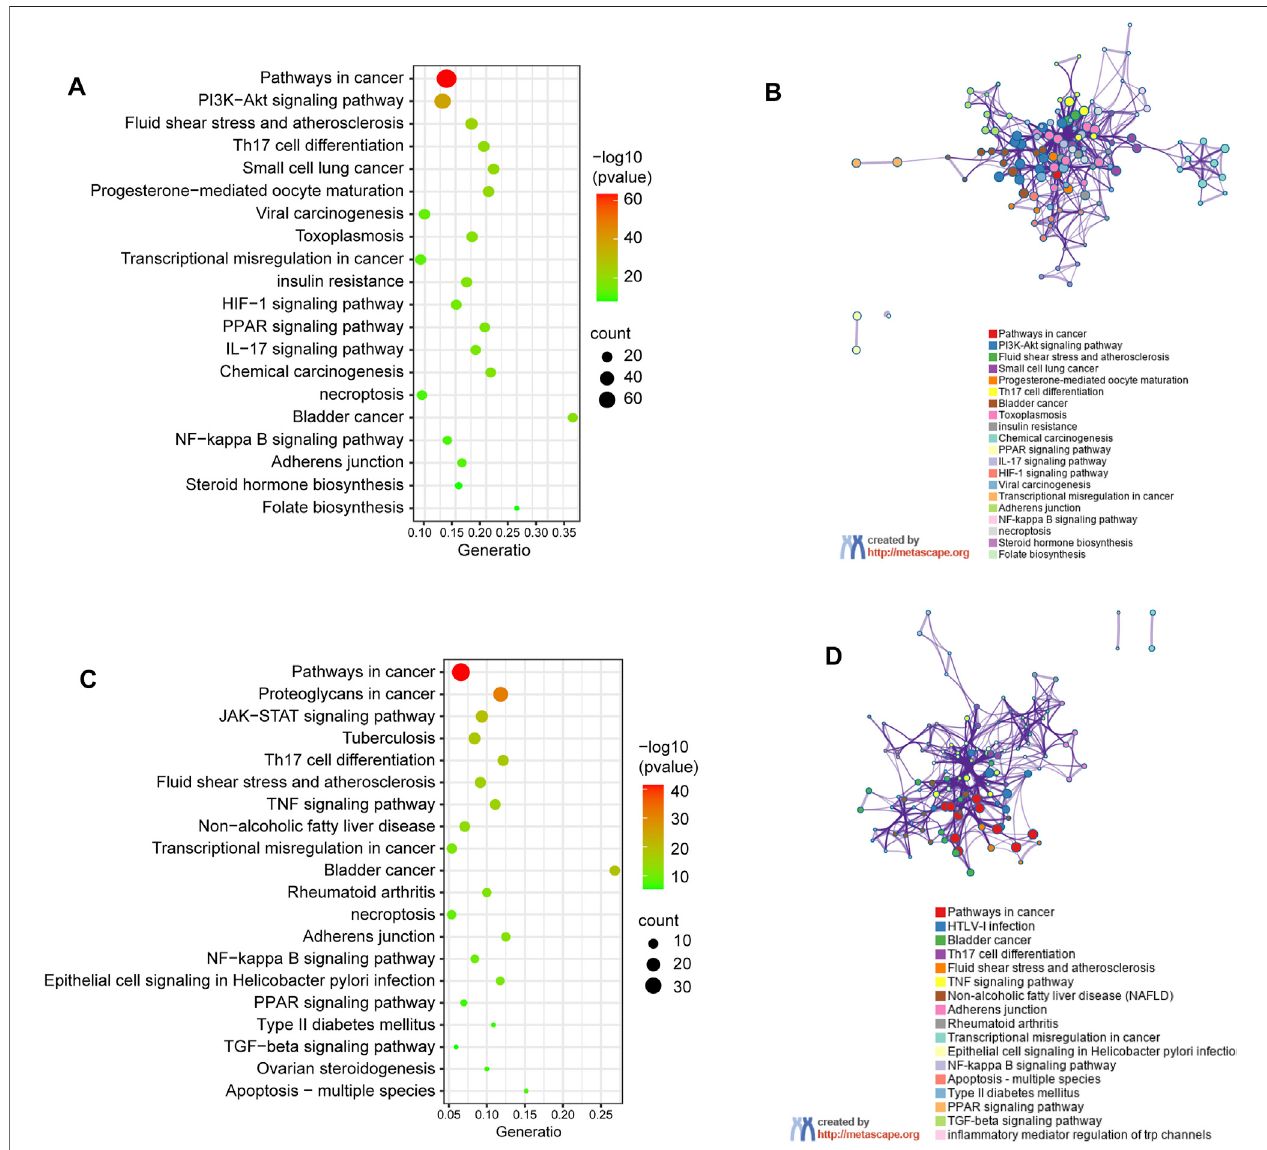
FIGURE4| KEGGpathwayenrichmentanalysisofgenesencodingproteinstargetedbycelastrol. (A) Signallingpathwaysinvolvedinpredictedtargetsofcelastrol. (B) Networkofenriched termsin (A) :coloredbyclusterID,wherenodesthatsharethesameclusterIDaretypicallyclosetoeach other. (C) Signallingpathways involved in intersection targets of celastrol and AIH. (D) Network of enriched terms in (C) .